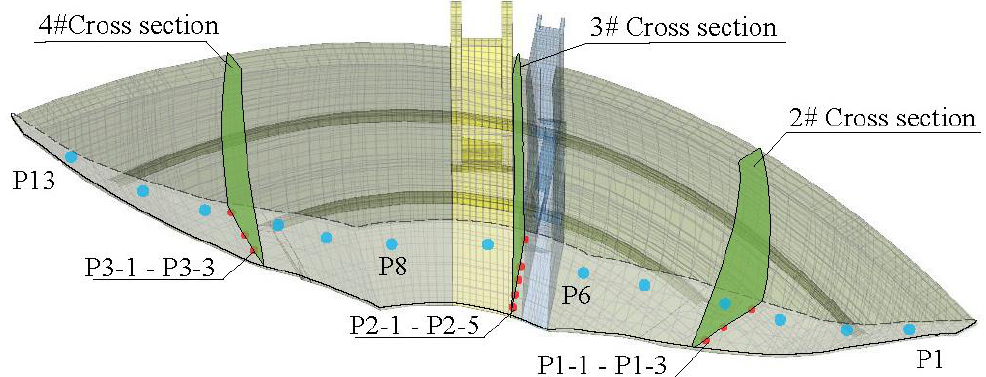
Figure 6. Layout of uplift pressure monitoring points in concrete arch